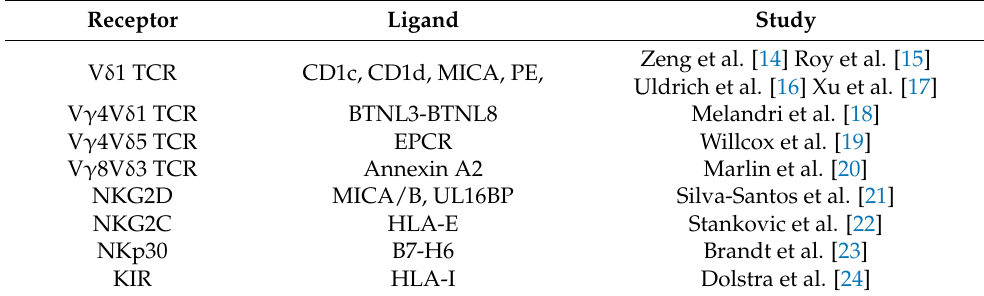
TCR: T cell receptor; CD: cluster of differentiation; BTNL: butyrophilin-like 3; EPCR: endothelial protein C receptor; NKG2D/C: natural killer group 2 D/C; MICA: MHC class I-related chain A; KIR: killer cell immunoglobulin- like